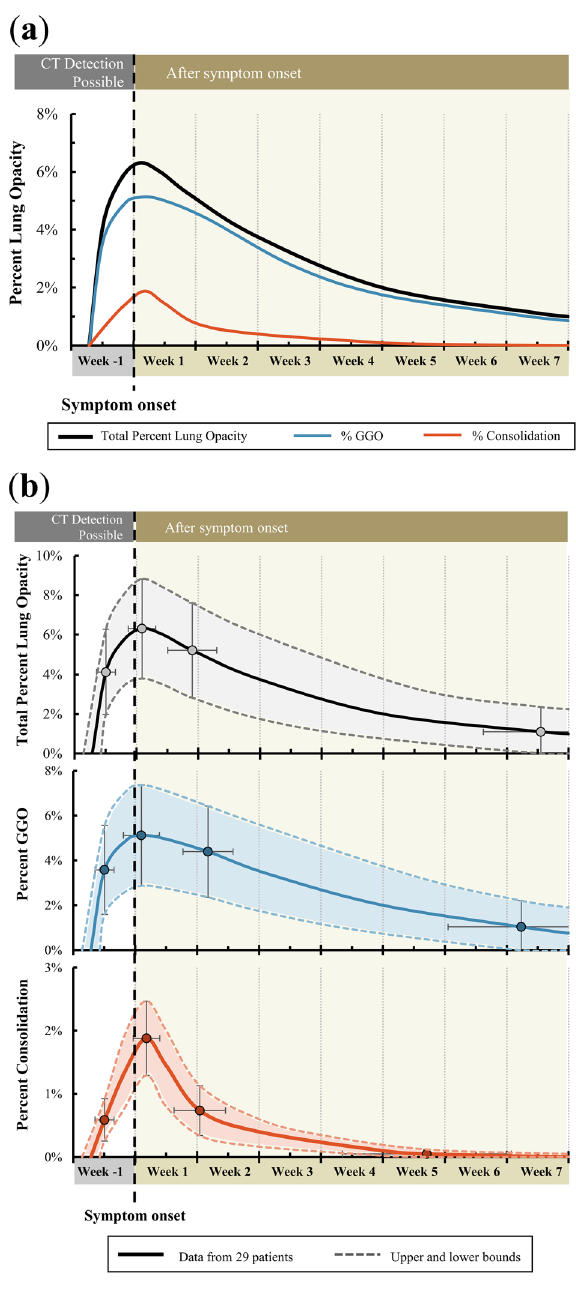
Figure 2. Dynamic curves of percent lung opacities for initially asymptomatic patients with COVID-19. ( a ) COVID-19 lung opacities, generalized from 29 patients with sequential CTs. Percent COVID-19 lung involvement (black) and opacity subtypes, including GGO (blue) and consolidation (red) are shown. ( b ) Detailed curves showing total percent COVID-19 lung opacity and subtype (GGO and consolidation). The upper and lower bounds and error bars represent the standard deviations. Data points are shown at the 4 generalized time points where percent lung involvement was calculated and